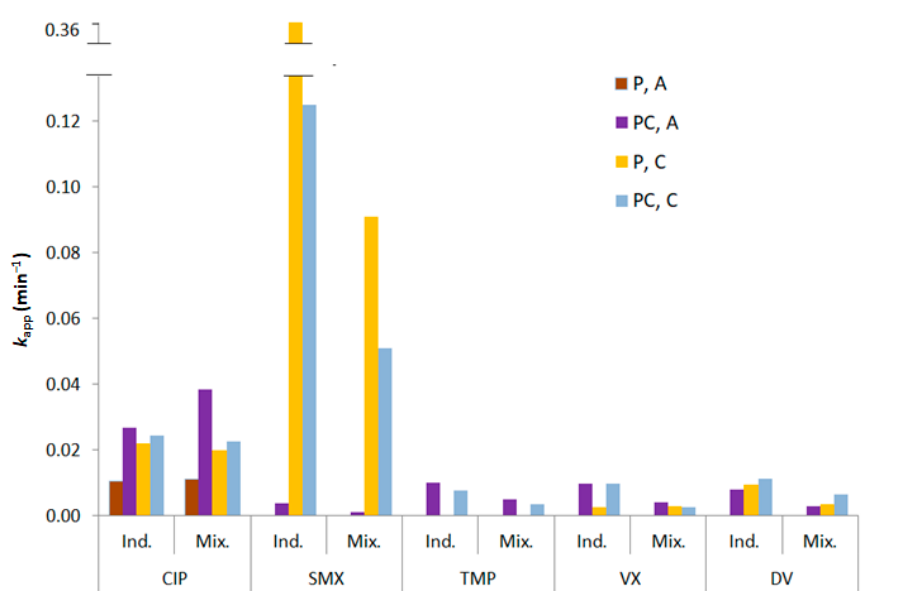
Figure 1. k app values for PhAC degradation individually (Ind.) and in a mixture (Mix.) in MQ water and at a concentration of 2 mg/L.